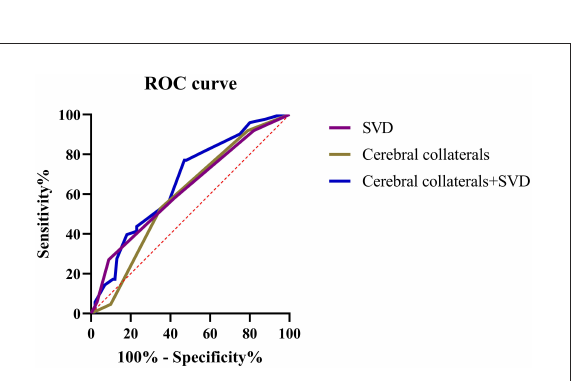
FIGURE4 ROC curves for the cerebral collateral circulation and SVD in predicting the unfavorable prognosis of patients with LAA stroke.